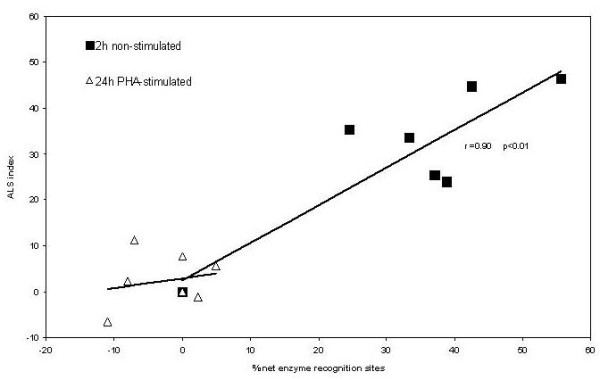
Pearson's correlational analysis between the percent of DNA-AP sites as evidenced by Exo III and ALS index in non-stimulated blood cells treated for 2 h and PHA-stimulated blood cells treated for 24 h with etoposide.